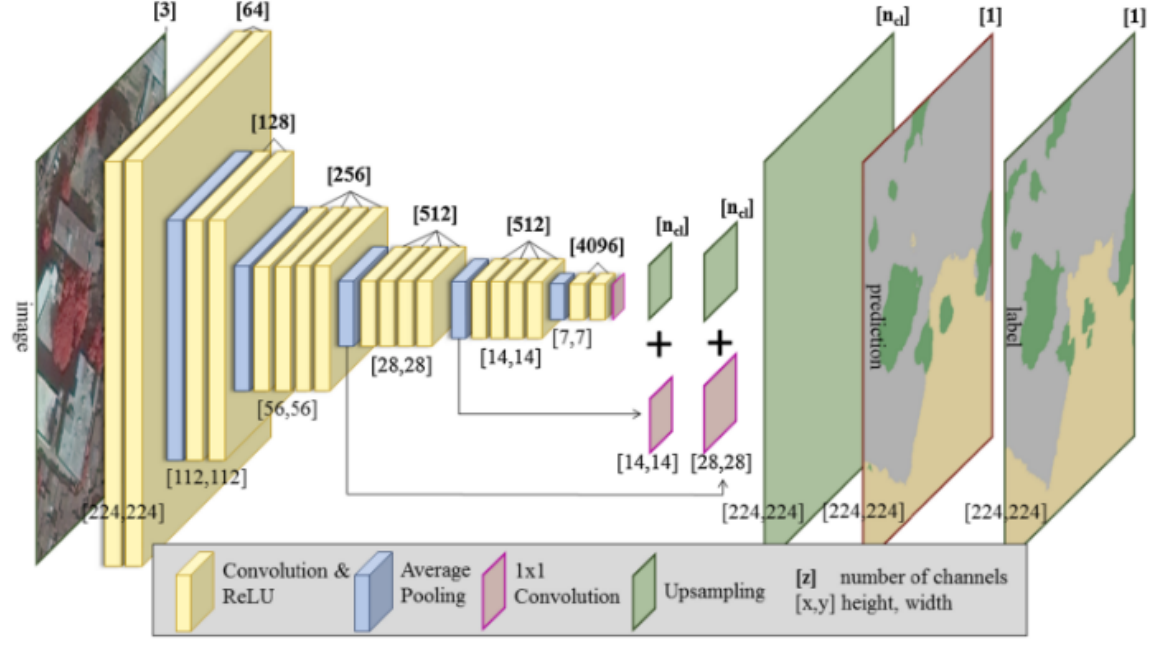
Figure 8. Structure of VGG19 [16].